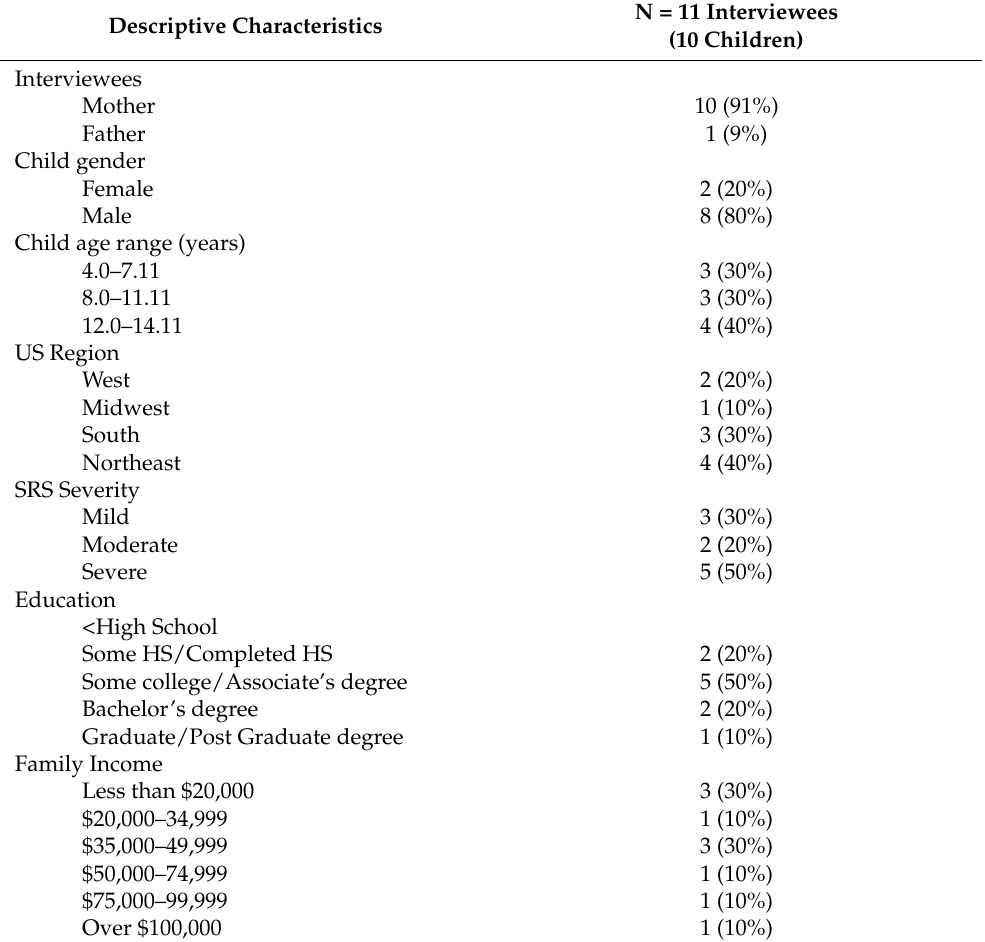
Table 1. Interview Participant